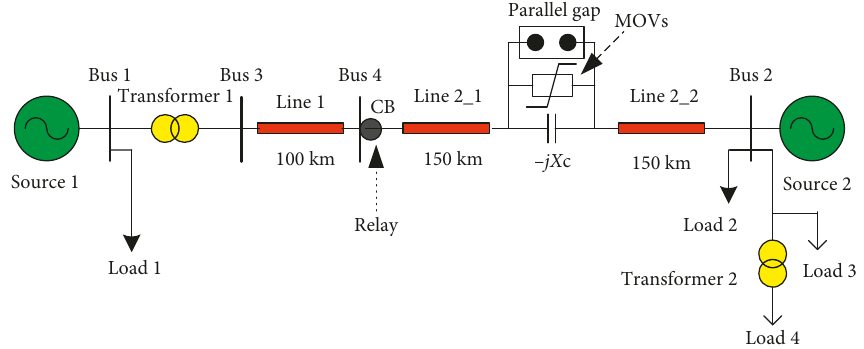
Figure 1: Single-line diagram of a series compensated power system